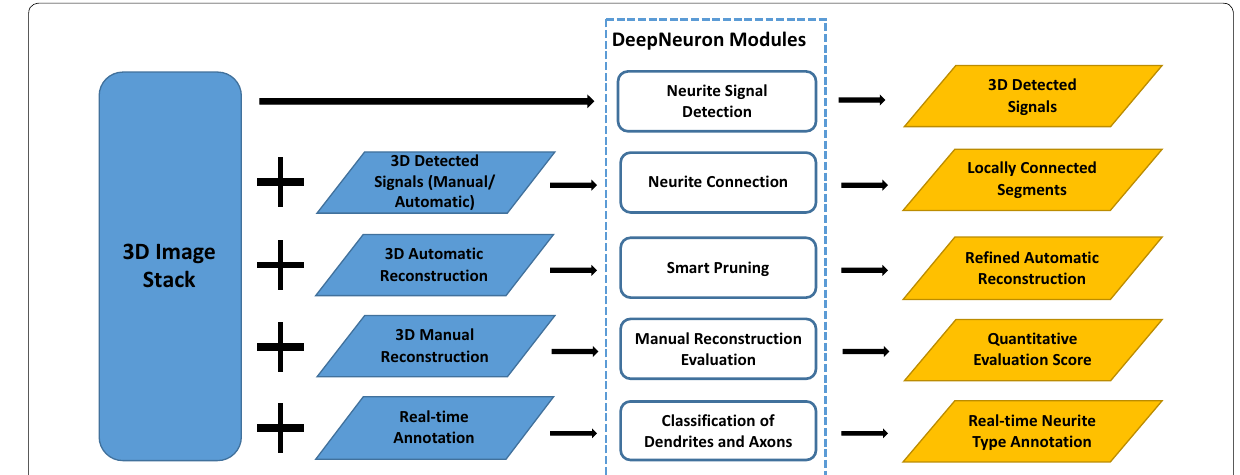
Fig. 1 The workflow of the Open Source DeepNeuron toolbox, which has five deep learning‑based modules. Each DeepNeuron module has one or more processing components. Neurite signal detection module (Sect. 2.1) uses convolutional neural networks (CNNs) to do foreground/ background classification. Neurite connection module (Sect. 2.2) uses a revised Siamese network [21, 22] to connect neurite structure from detected neuron signals. Smart pruning module (Sect. 2.3) refines a neuron’s morphology by using CNN models to filter out false positives. Manual reconstruction evaluation module (Sect. 2.4) uses the output of CNNs as quality scores to evaluate reconstructions. Finally, dendrites/axons classification module (Sect. 2.5) uses CNNs to perform multiclass classification to differentiate axons, dendrites, and background. Note that all the actual deep learning networks in our five modules can be replaced with other network models or user’s own